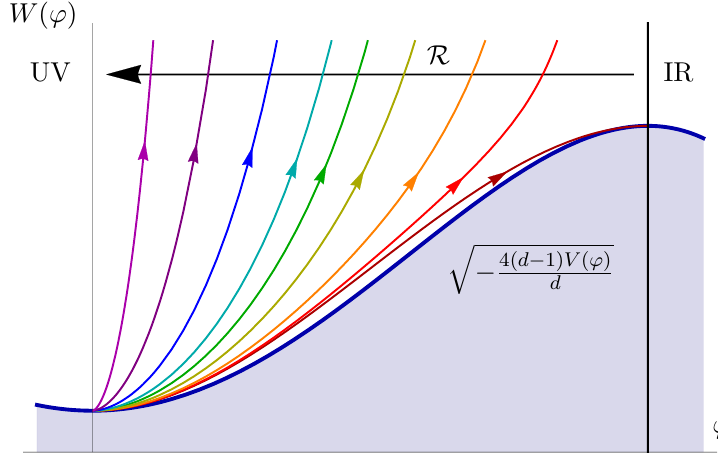
Figure 1. Family of holographic RG (cid:13)ow solutions A R;’ ( u ) ; ’ R;’ ( u ) with di(cid:11)erent values of (cid:0) (cid:0) dimensionless curvature R . Here the di(cid:11)erent solutions are represented by plotting the correspond- (cid:0) (cid:1) ing function W ( ’ ) = (cid:0) 2( d (cid:0) 1) dA u ( ’ ) . A (cid:13)ow with R = 0 has its end point ’ 0 at the minimum du of the potential. When R is increased the end point moves closer to the maximum of the potential with ’ 0 ! ’ max for R ! 1 . On this family of holographic RG solutions parameterised by R we then de(cid:12)ne functionals F ( R ) = F [ A R;’ ; ’ R;’ ]. For these functionals the notion of curvature-RG (cid:0) (cid:0) (cid:13)ow is then de(cid:12)ned as the response to a change in R with the UV identi(cid:12)ed with R ! 1 and the IR given by R !